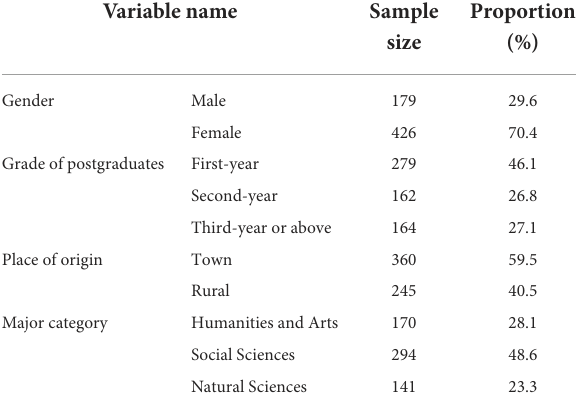
TABLE 1 Basic characteristics of samples ( N =